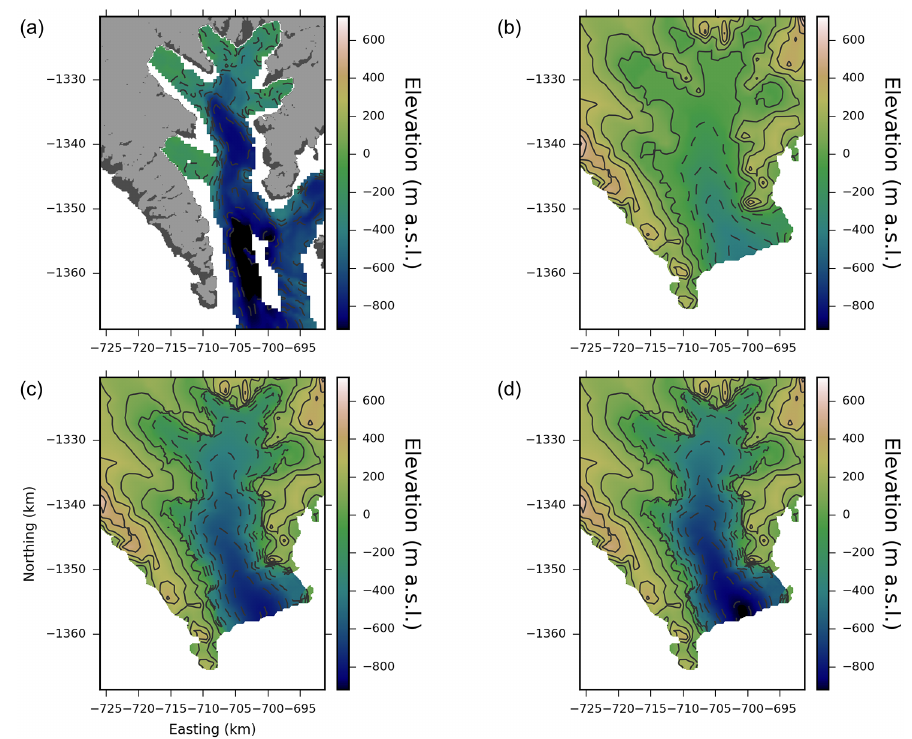
Figure 10. The area of interest close to Cape York displaying (a) the land mask of the area of interest (Morlighem et al., 2014) with ice (light grey), ice-free land (dark grey) and ocean (white) along with the OBS1516 elevations; (b) Bed2013 elevation; (c) Bed2013 combined with the SynthIBCAO synthetic geometry; and (d) Bed2013 with the inclusion of the SynthOBS synthetic geometry. SynthIBCAO and SynthOBS are only used within the ocean regions of the land